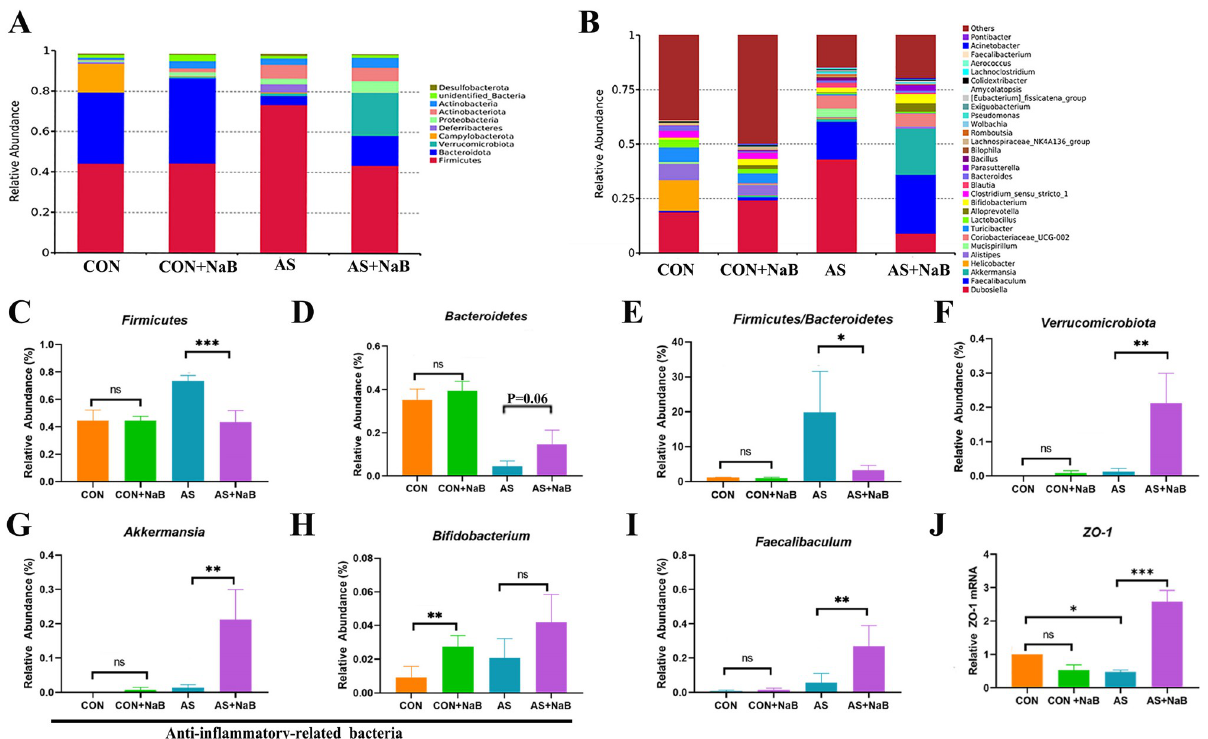
Fig 6. NaB consumption modulated the composition of gut microbiota. (A-I) The phylum and the genus levels. (J) The mRNA expression level of ZO-1 in different groups. � P < 0.05, �� P < 0.01, ��� P < 0.001. ns, no significant difference.